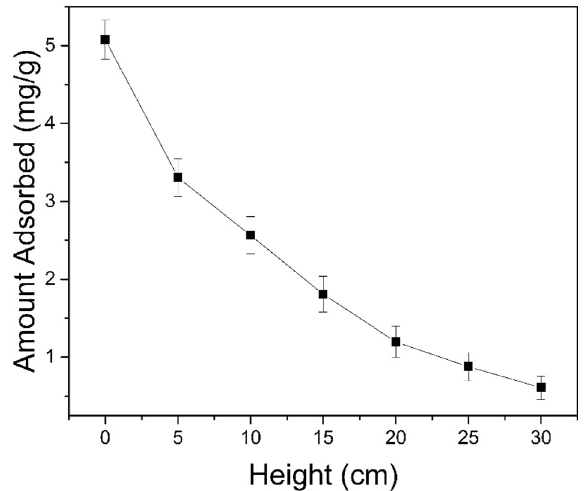
Figure 9. The distribution of the Sb(III) sorption GAD at different heights (from the column base) at the point of column